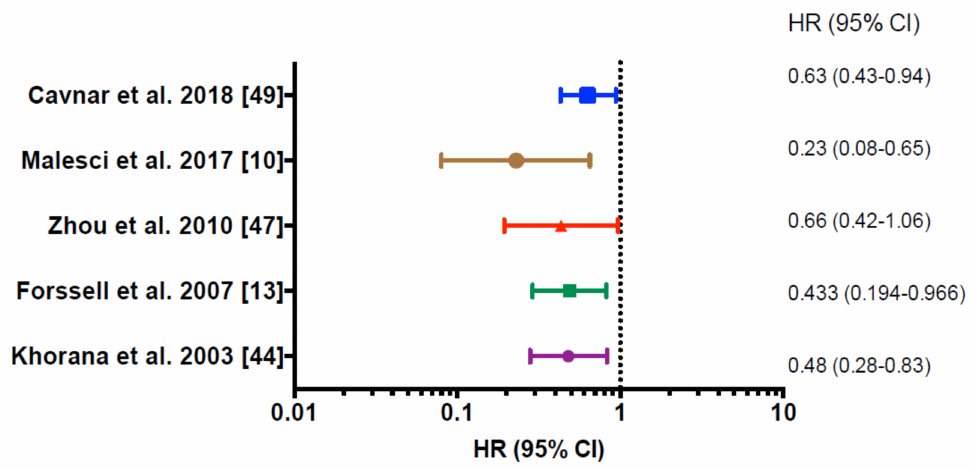
Figure 1. Forest plot showing significant prediction for survival in multivariate regression analysis of di ff erent clinical studies on colorectal cancer. HR, Hazard Ratio; 95% CI 95%, confidence interval. Hazard ratios < 1.00 represent a decreased probability of death, hazard ratios > 1.00 represent an increased probability of death; p < 0.05 was considered statistically